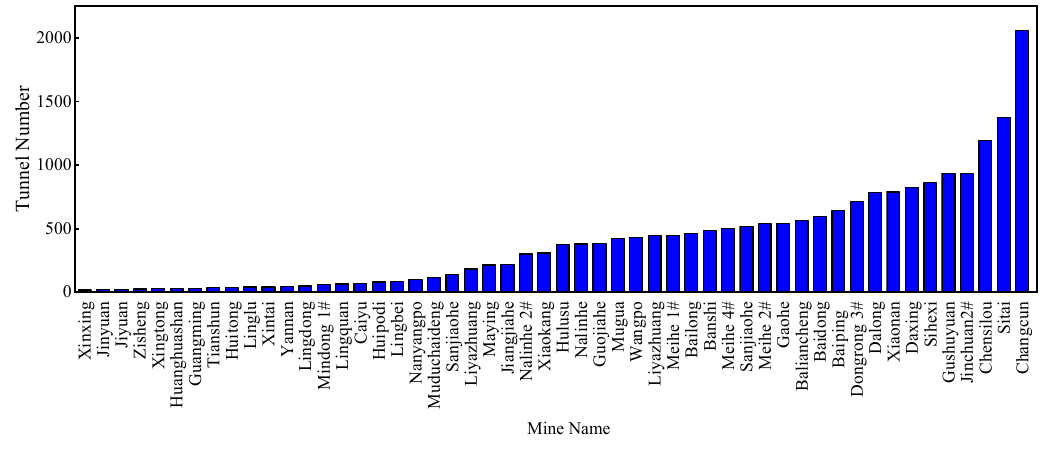
Figure 1. The number of tunnels in mines in China.